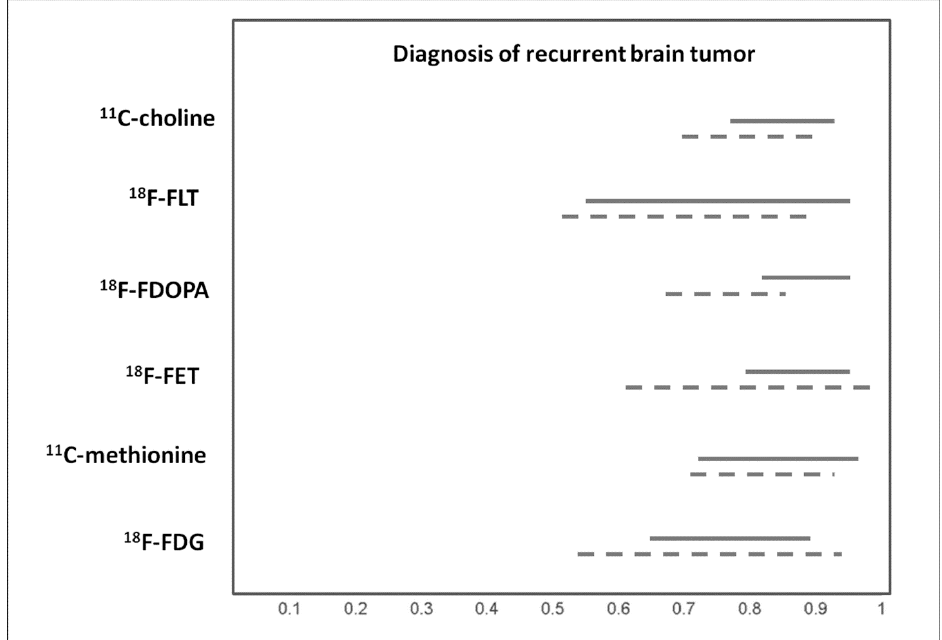
Figure 4. Graph showing 95% confidence intervals of sensitivity (continuous line) and specificity (dashed line) of PET with di ff erent tracers for diagnosis of recurrent brain tumor, according to (dashed line) of PET with different tracers for diagnosis of recurrent brain tumor, according to published published meta-analyses.